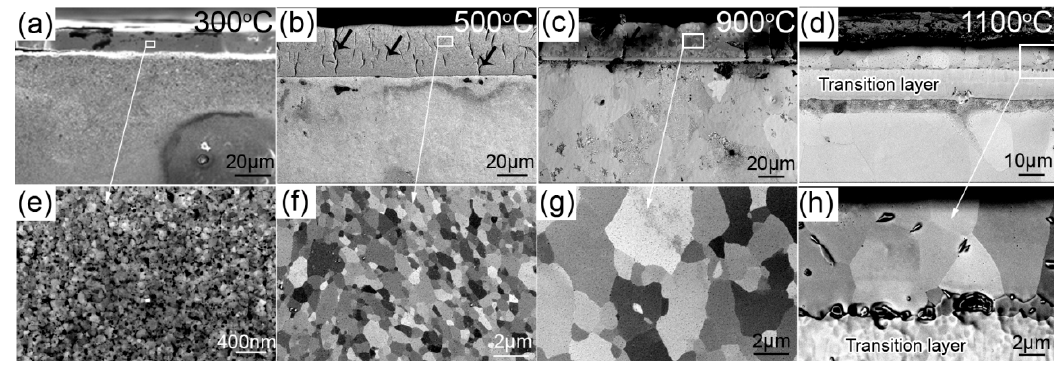
Figure 2. BSEI images showing microstructure and micro-crack evolution of the Cr-coating with annealing temperature: ( a ) A300; ( b ) A500; ( c ) A900; ( d ) A1100. Figures ( e – h ) are the corresponding enlarged images of ( a – d ), respectively.